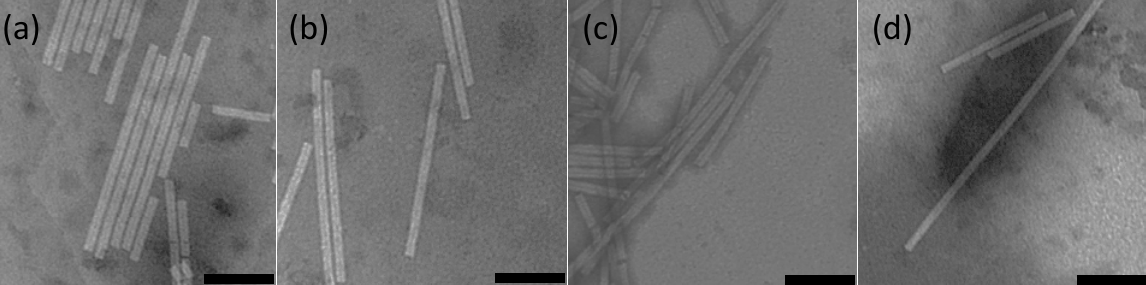
Figure 7. Electron micrographs of in vitro encapsidated (IVE) OA-containing RNA with TMV CP. Grids were coated with 100–200 µg/mL of in vitro encapsidated particles, negatively stained with 1% phosphotungstic acid (PTA), air dried, observed with a Philips CM120 microscope and imaged with Gatan MegaScan 795 digital camera. Black bar represents 100 nm: ( a ) Wild type TMV virions approximately 300 nm in length; ( b ) TMV RNA encapsidated with TMV coat proteins are approximately 300 nm in length; ( c ) FHV-C2-GFP-OA RNA encapsidated with TMV coat proteins approximately 187 nm in length; and ( d ) SFV-GFP-OA RNA encapsidated with TMV coat proteins approximately 600 nm in length. (a